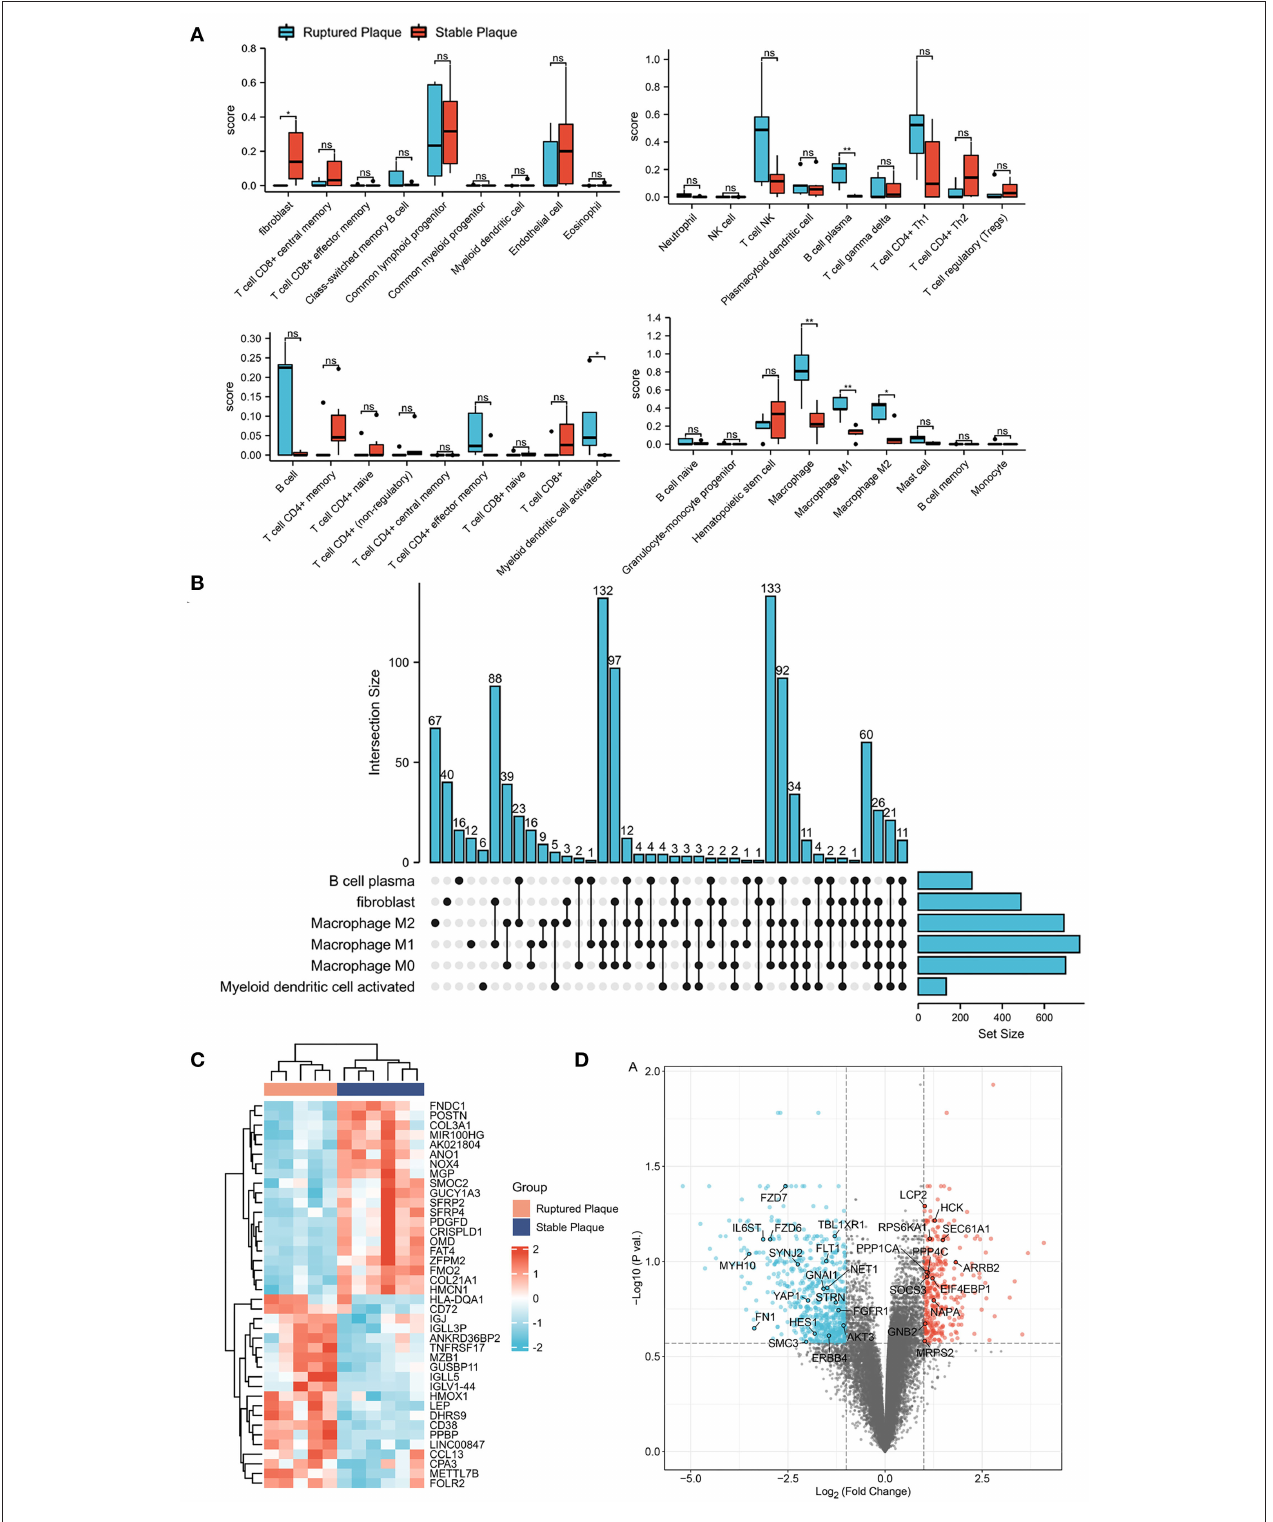
FIGURE 1 | Identification of differentially expressed genes (DEGs) in ruptured plaques and stable plaques. (A) Abundance of immune cells estimated by the xCell algorithm in GSE41571. (B) Upset diagram of plasm B cells, fibroblasts, activated myeloid dendritic cells, M0, M1, and M2 Macrophages-related DEGs with Pearson correlation coefficients > 0.6. (C,D) Heatmap (C) and Volcano plot (D) of DEGs between ruptured plaques and stable plaques.